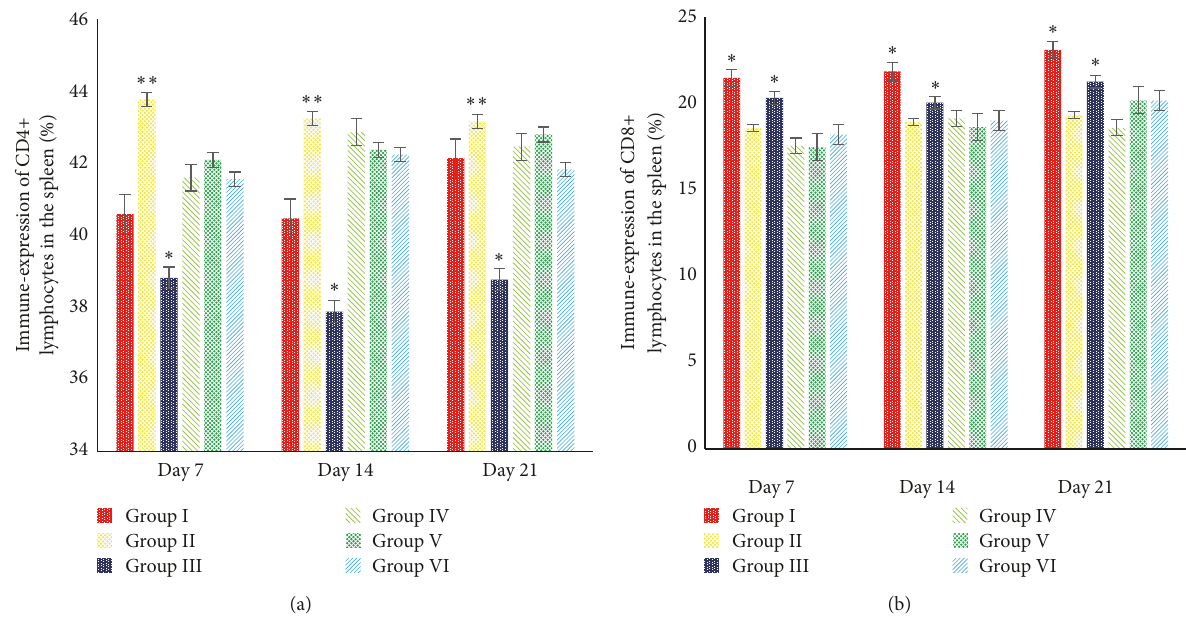
Figure 6: Effects of 5% SAP on the immune-expression of CD4+ (a) and CD8+ (b) lymphocytes in the spleen of broiler chickens fed a diet naturally contaminated with AF at 7, 14, and 21 days of age. ∗ / ∗∗ The different superscript showed significantly different values ( P < 0.05).